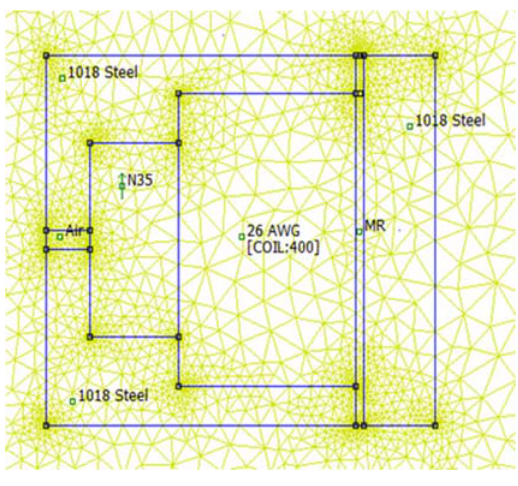
Fig. 5. FEMM model of NC MR